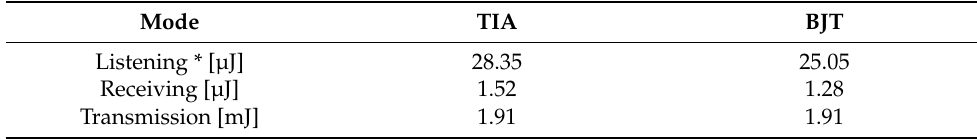
Table 4. Energy consumption of BJT and TIA amplifiers.